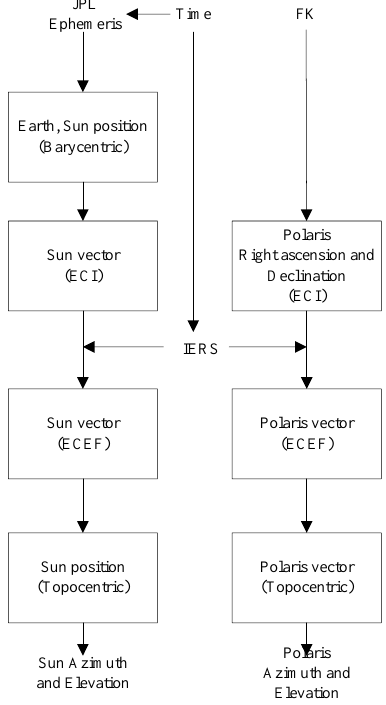
Figure 9 Calculation procedure of azimuth, elevation of the sun and the Polaris